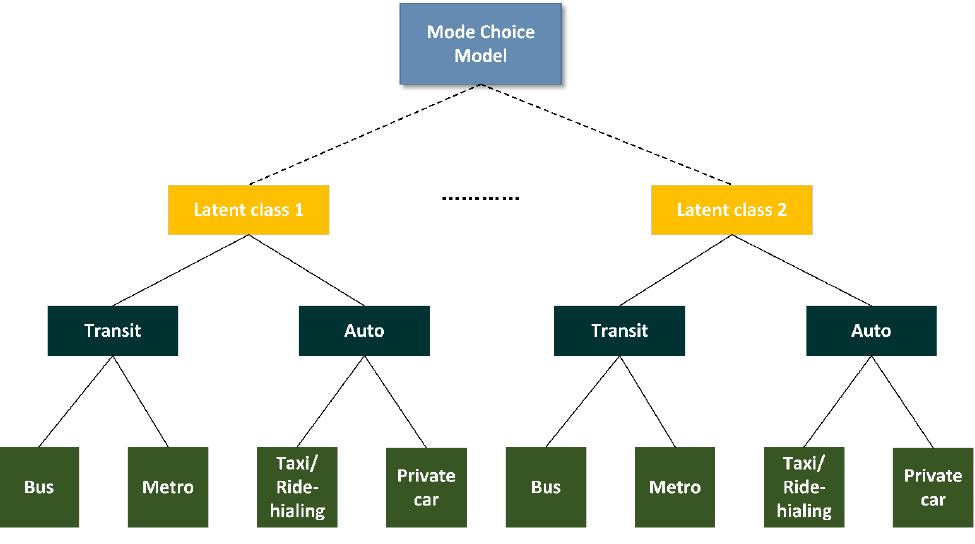
Figure 4. Model structure.